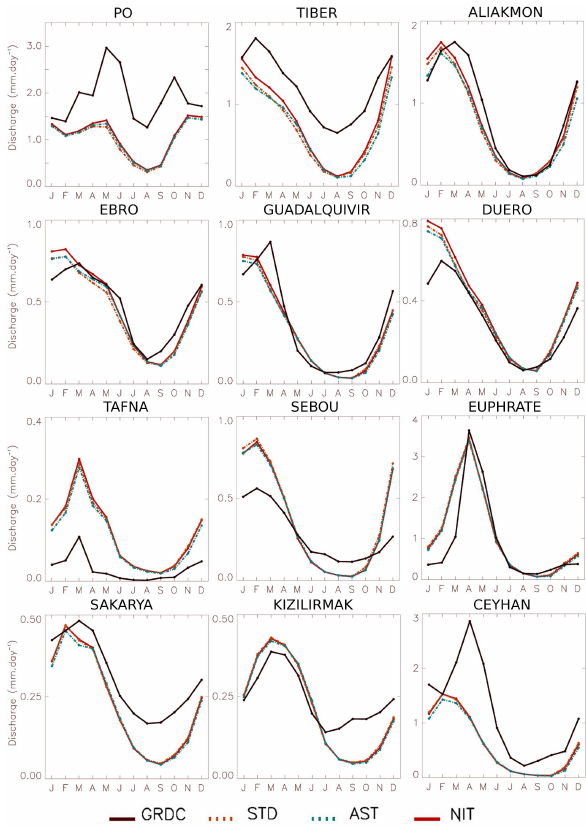
Fig. 11. As in Fig. 7, except for the Mediterranean rivers of the MBS area and historical GRDC climatologies (green dots in Fig. 2). The drainage areas used by TRIP are Po (67519km 2